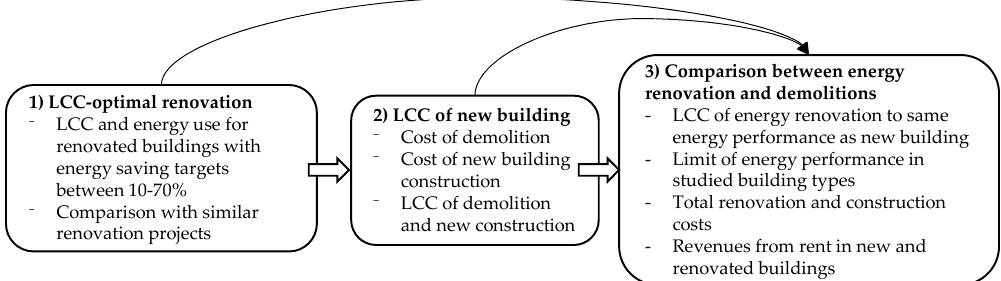
Figure 3. Overview of methodological approach and results from the three parts. LCC—life cycle cost.